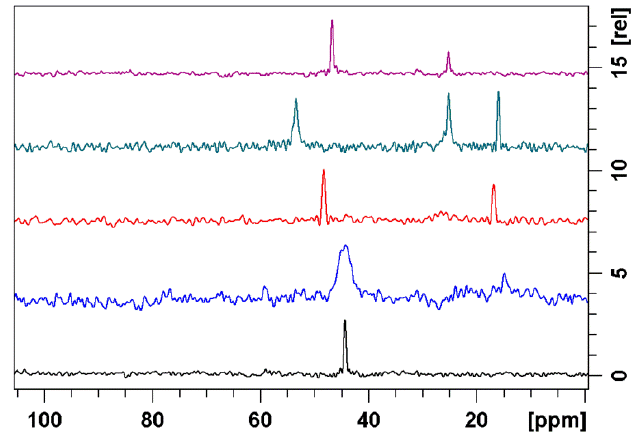
Figure 2. Solid − state 15 N CPMAS NMR spectra of azithromycin, 1a, 1b, 1c and azithromycin algycone (from top to bottom).